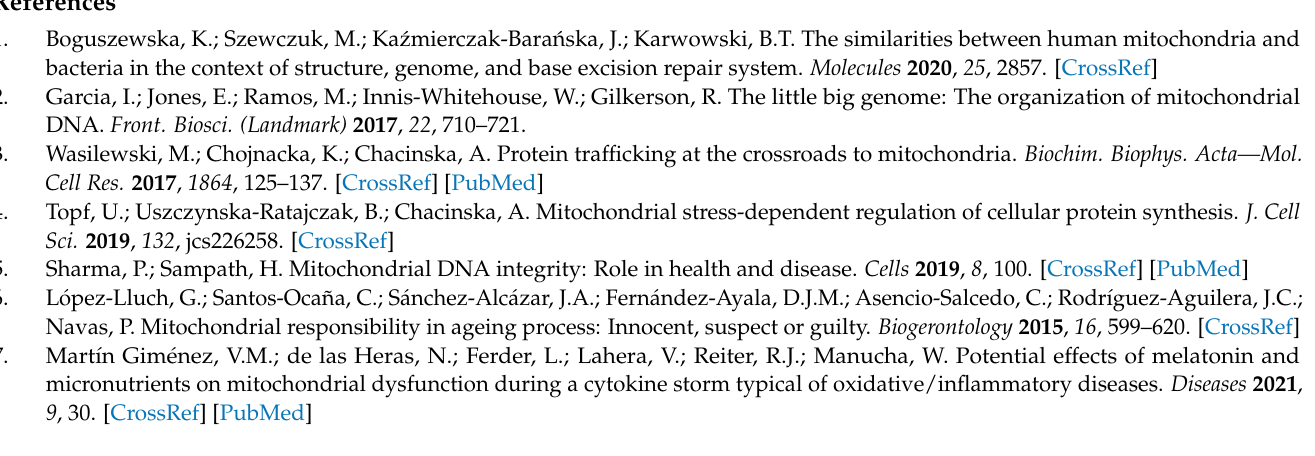
Figures S10 and S11: Graphical representation of the results for ScdG and RcdG, Figure S12: Endonu- clease activity [%] of ScdG vs. RcdG—comparison of individual strands, Figure S13: Polymerase activity [%] of ScdG vs. RcdG—comparison of individual strands; Figure S14: Functional activity test of mitochondrial